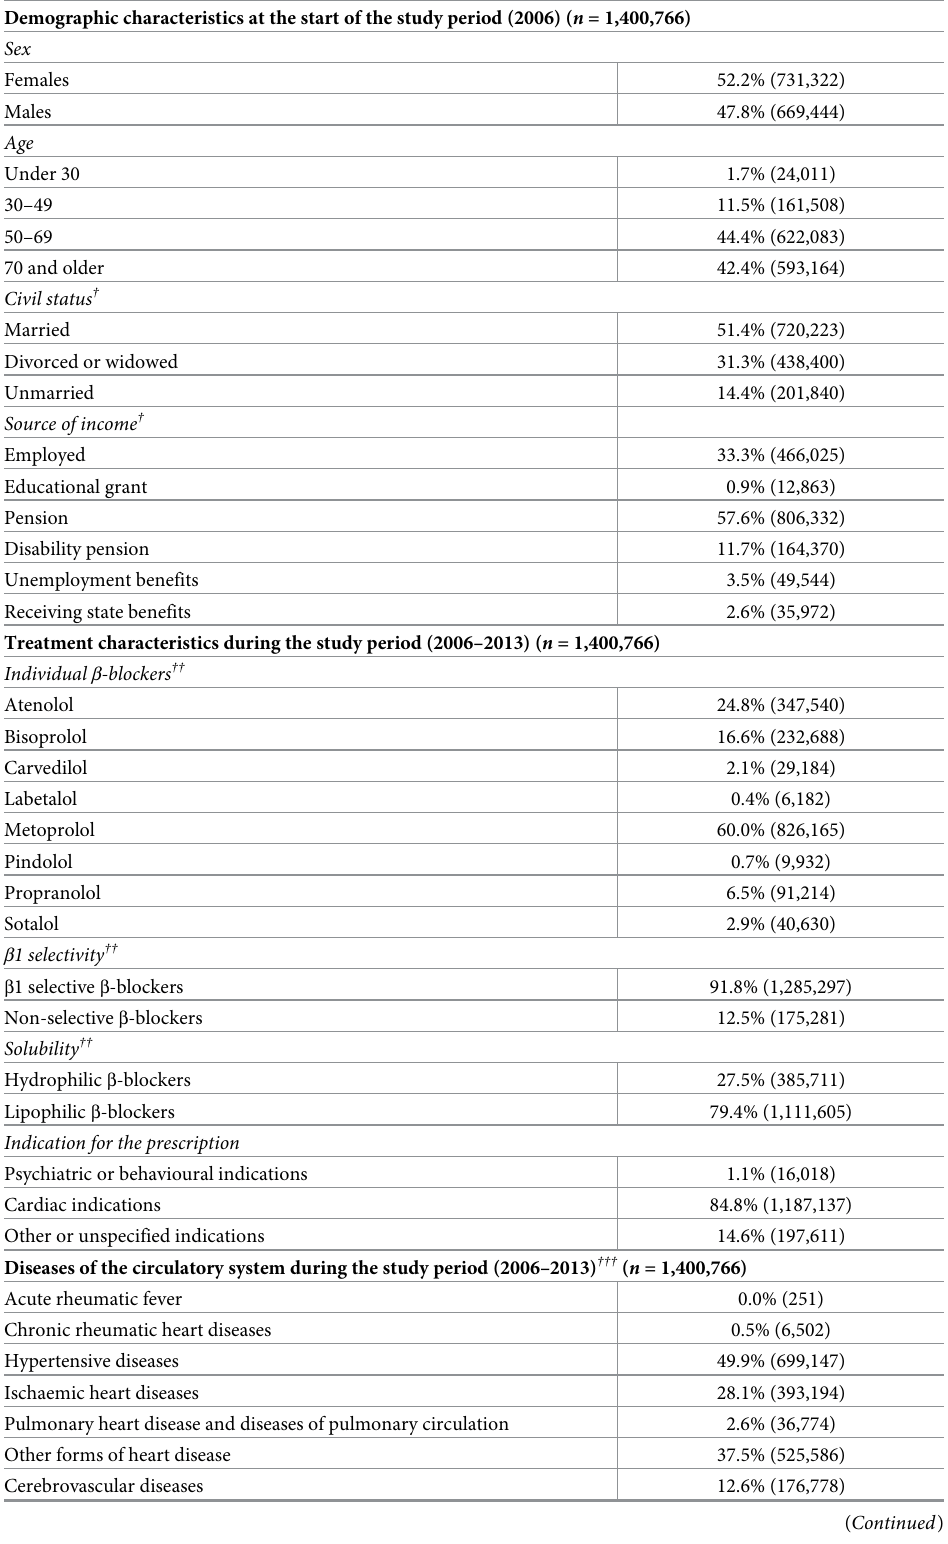
Table 1. Baseline characteristics of the study